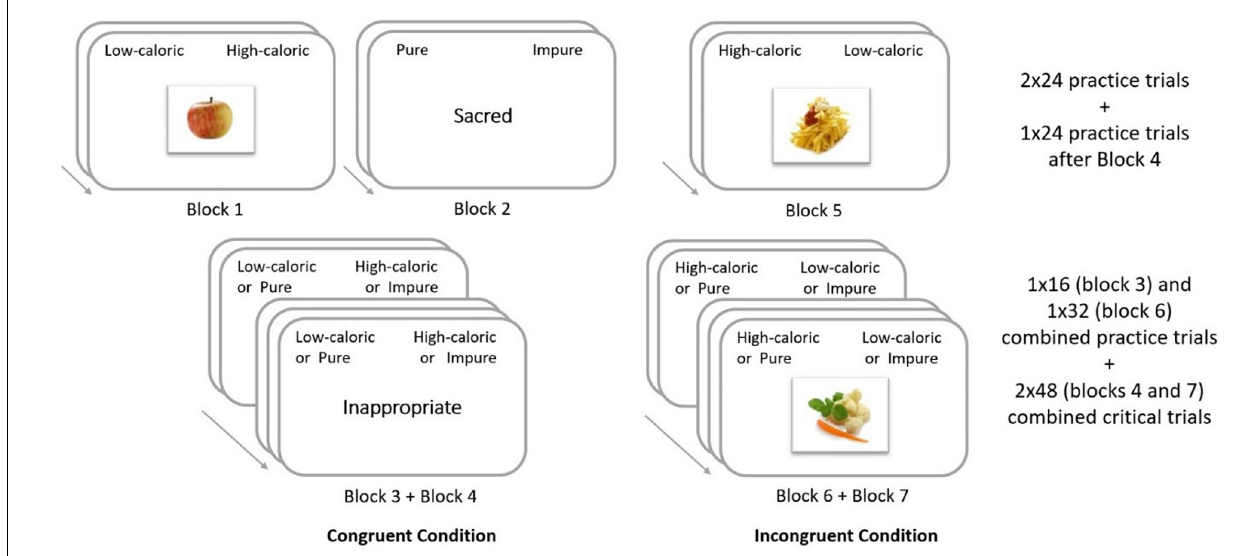
FIGURE 3 | Design of the Implicit Association Test between low-caloric versus high-caloric foods and morally “pure” versus “impure” attributes. Interstimulus Interval (ISI): 1,650 ms in practice blocks with feedbacks, ISI: 1,150 ms in combined blocks. In this study, the IAT was administrated in French. For the purpose of this paper, this figure is an English translation of the